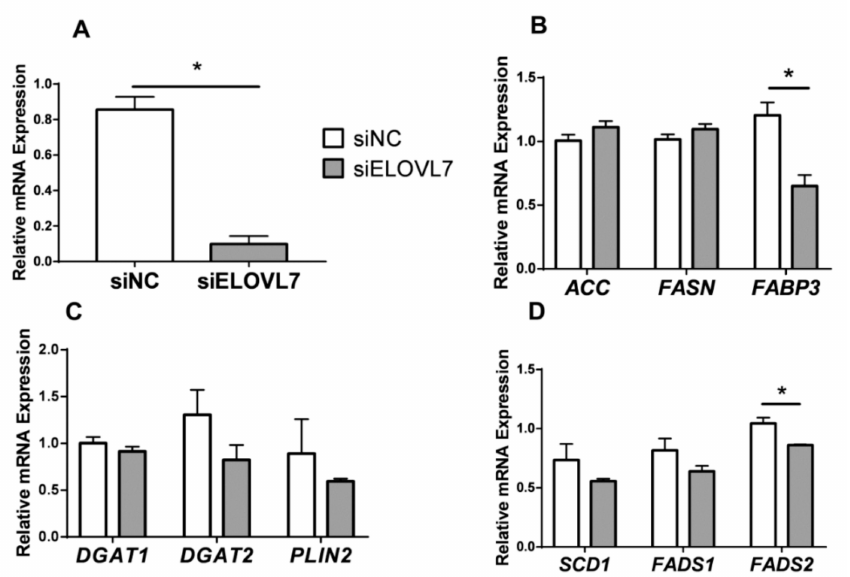
Figure 4. Knockdown of elongation of very-long-chain fatty acid-like fatty acid elongase 7 ( ELOVL7 ) altered gene expression. Goat mammary epithelial cells (GMEC) were incubated with siRNA target ELOVL7 (siELOVL7) or negative control (siNC) for 48 h, and then collected for mRNA extraction. Panel A: mRNA expression of ELOVL7. Panel B: mRNA expression of genes related to de novo synthesis ( ACC and FASN ) and transport ( FABP3 ). Panel C: mRNA expression of genes related to triacylglycerol synthesis ( DGAT1 , DGAT2 , and PLIN2 ). Panel D: mRNA expression of genes related to desaturation ( SCD1 , FADS1 , and FADS2 ). Values are means ± SEM from 3 individual cultures. The data were determined via Student’s t-test. * p < 0.05 compared with control